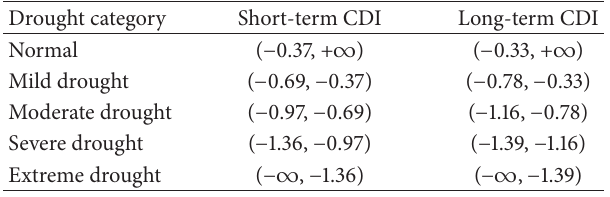
Table 4: Drought categories of the short-term/long-term CDI.